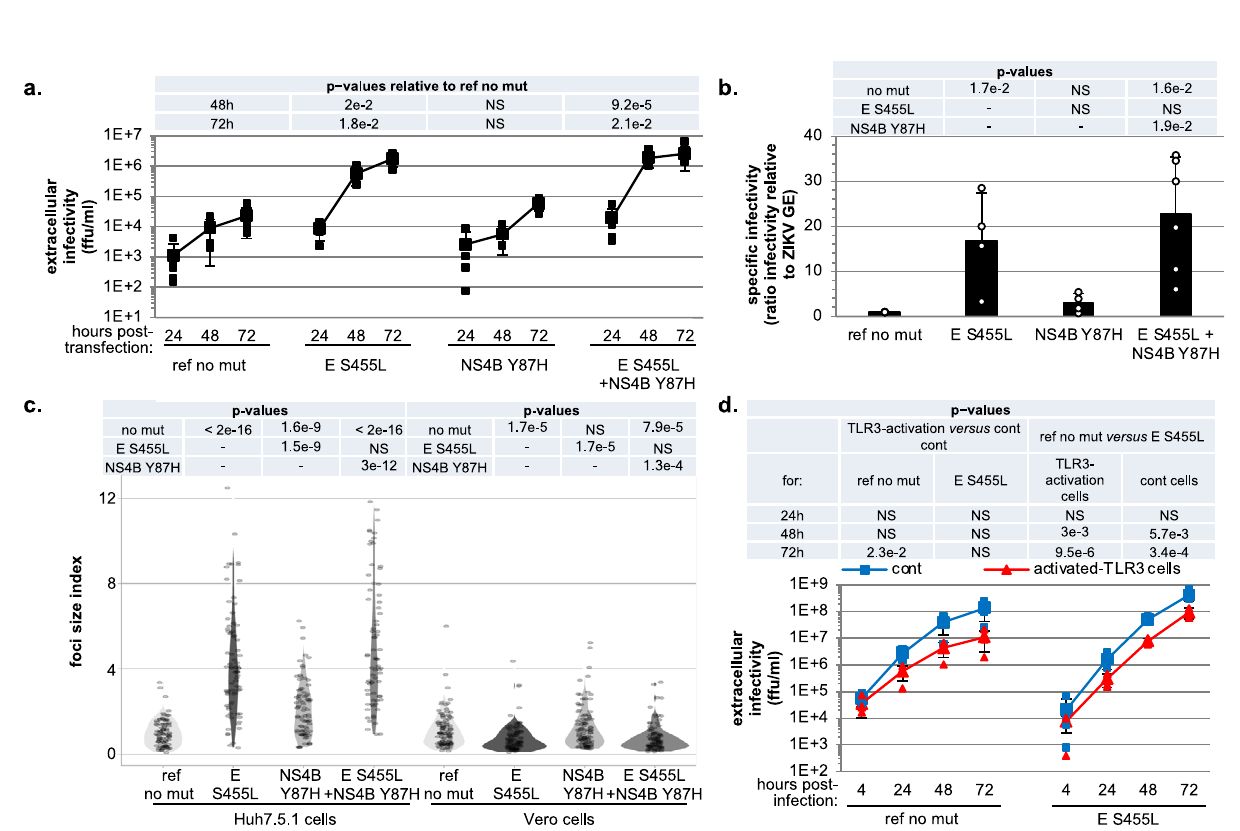
Fig. 4 Introduction of the selected non-synonymous mutations into a ZIKV molecular clone. ZIKV genome bearing the selected mutations (i.e., single S455L mutation in E, Y87H in NS4B and combined E S455L and NS4B Y87H mutations), and as a reference ZIKV genome without the mutation (i.e., ref no mut), were transfected in Huh7.5.1 cells. a Time-course quanti fi cation of infectious viral production at the indicated times post-transfection. Results of 4- to-6 independent experiments; mean ± SD; p-values as indicated in the table above the graph and relative to the reference (ref no mut). b Quanti fi cation of the speci fi c infectivity (as in Fig. 1a) in the viral supernatants harvested at 72 h for ZIKV genome mutants or not. Results are the mean ± SD relative to the reference virus set to 1 for each independent experiment; 4-to-6 independent experiments. The p-values indicated in the table correspond to one-by-one comparisons of the condition/mutant displayed below in the graph with conditions/mutants indicated on the left side of the table. c Analysis of the focus size index of the indicated mutated or reference ZIKV determined in Huh7.5.1 and Vero cells, as indicated, for supernatants harvested at 72 h post- transfection. The quanti fi cations are displayed by violin plots, determined as in Fig. 2b. Results of 4 independent experiments; p-values as indicated in the table above the graph. d Time-course analysis of the replication of the E S455L mutant versus reference virus (ref no mut) assessed in activated-TLR3 Huh7.5.1 cells (red lines) as compared to control cells (blue lines). Quanti fi cation of the intracellular ZIKV genome levels at the indicated times post- infection at MOI 0.005; 4 independent experiments; mean ± SD. The statistical comparison of intracellular ZIKV GE levels for the same target cells and between mutant and reference virus is indicated in the table at the top of the graphs with indicated p -values and NS: p >